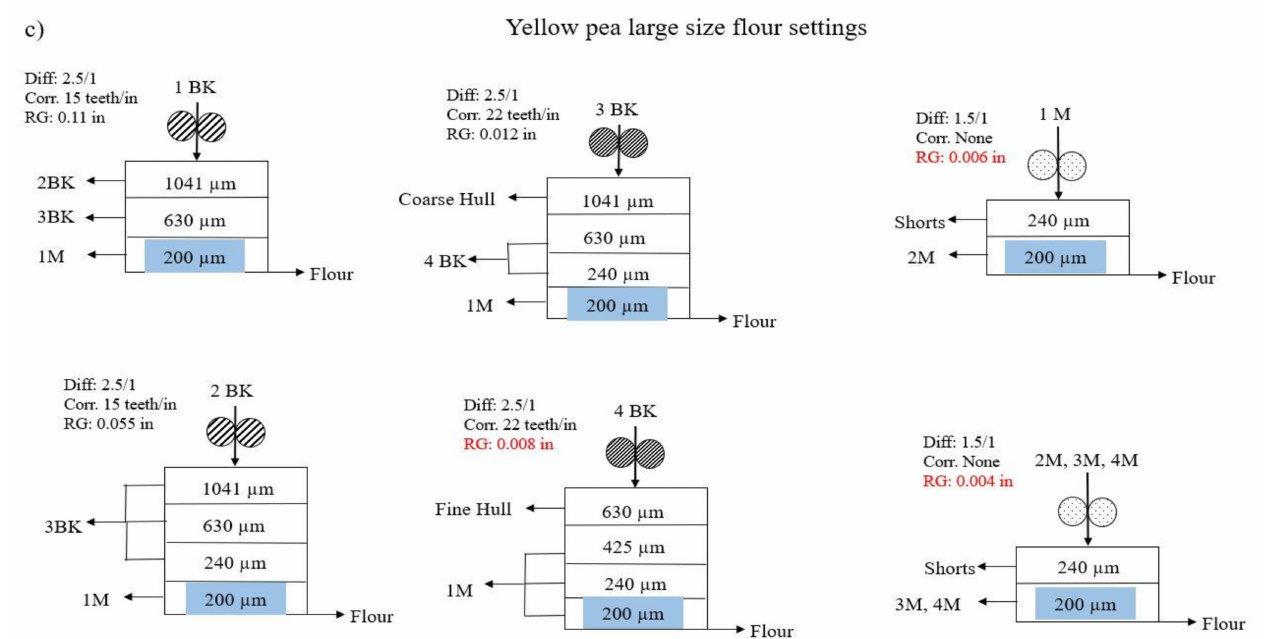
Figure 2. Roller milling flowsheet to obtain ( a ) small yellow pea flour ( ≤ 75 µ m), ( b ) medium yellow pea flour ( ≤ 150 µ m), and ( c ) large yellow pea flour ( ≤ 200 µ m); (Diff—Differential speed; Corr—Corrugations; RG—Roller Gap; BK—Break, M—Middling).